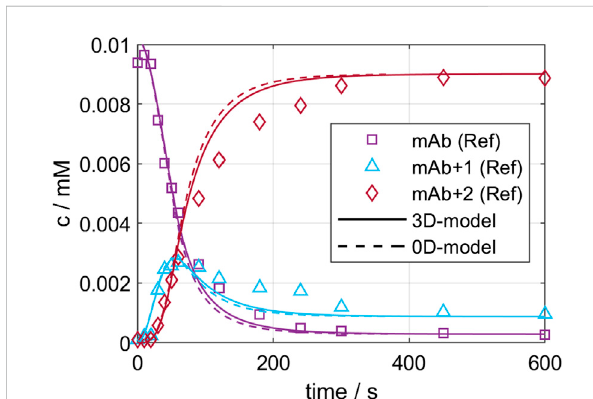
FIGURE 5 Comparison of the Δ DAR within the fi rst 200 s for all three studied vessels. Payload addition was simulated over the course of 60